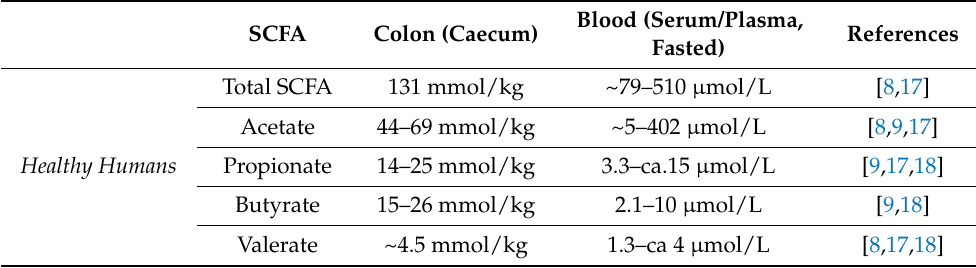
Table 1. Physiological concentration of SCFAs in the healthy human colon and blood (fasted), as reported in the literature. Note that higher concentrations may be found in arterial blood compared to venous blood